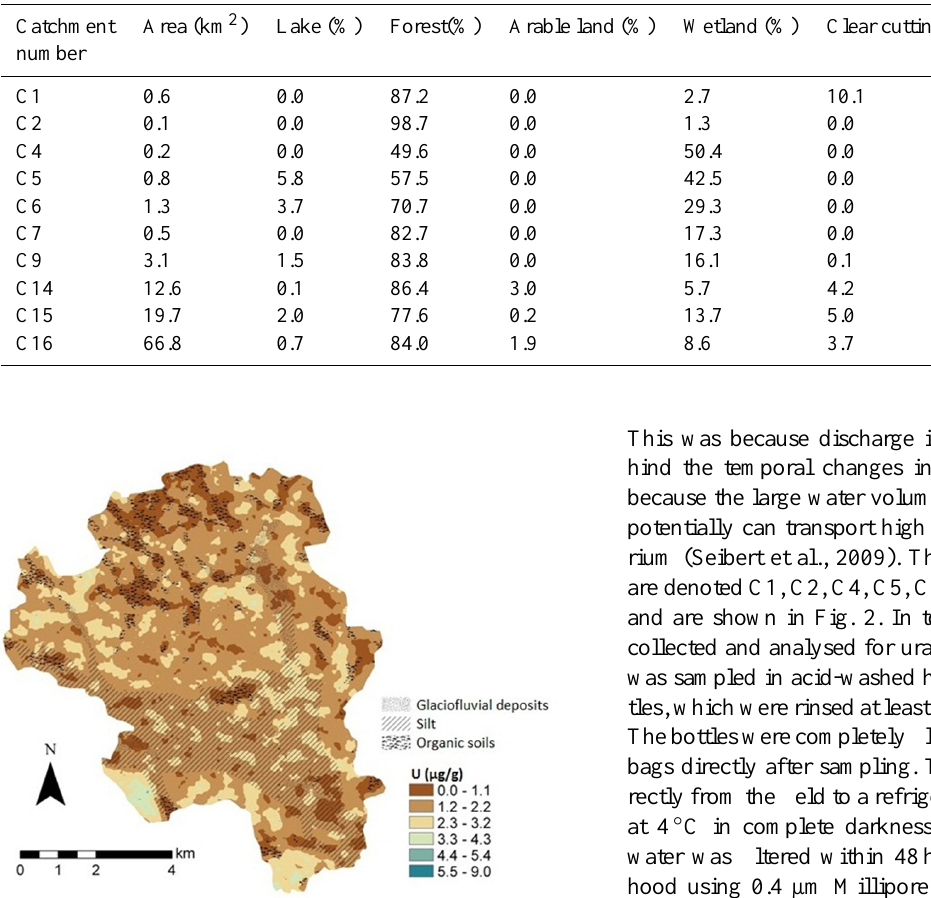
Table 1. Area and landscape characteristics of the investigated catchments.